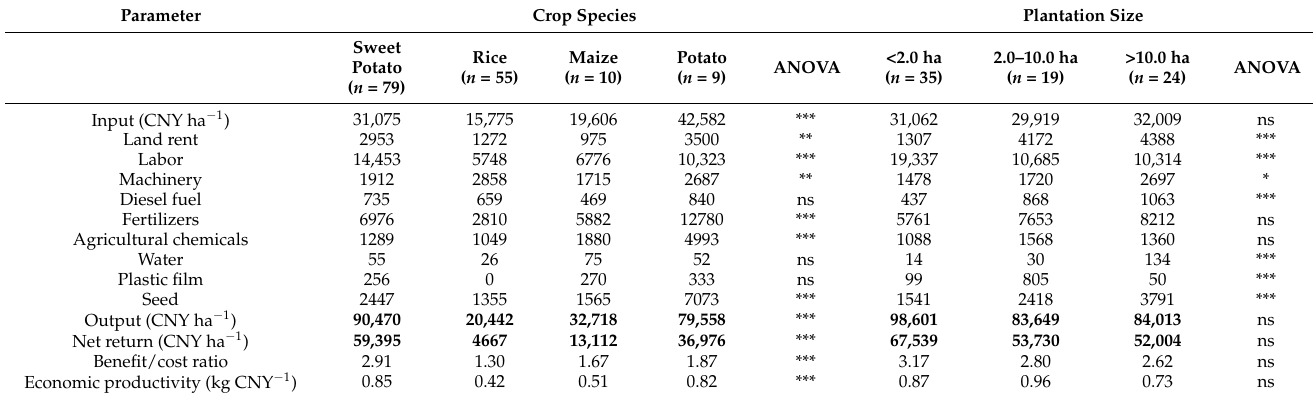
Table 6. Economic input and output of different crop production (including sweet potato, rice, maize, and potato) and different plantation sizes of sweet potato production in